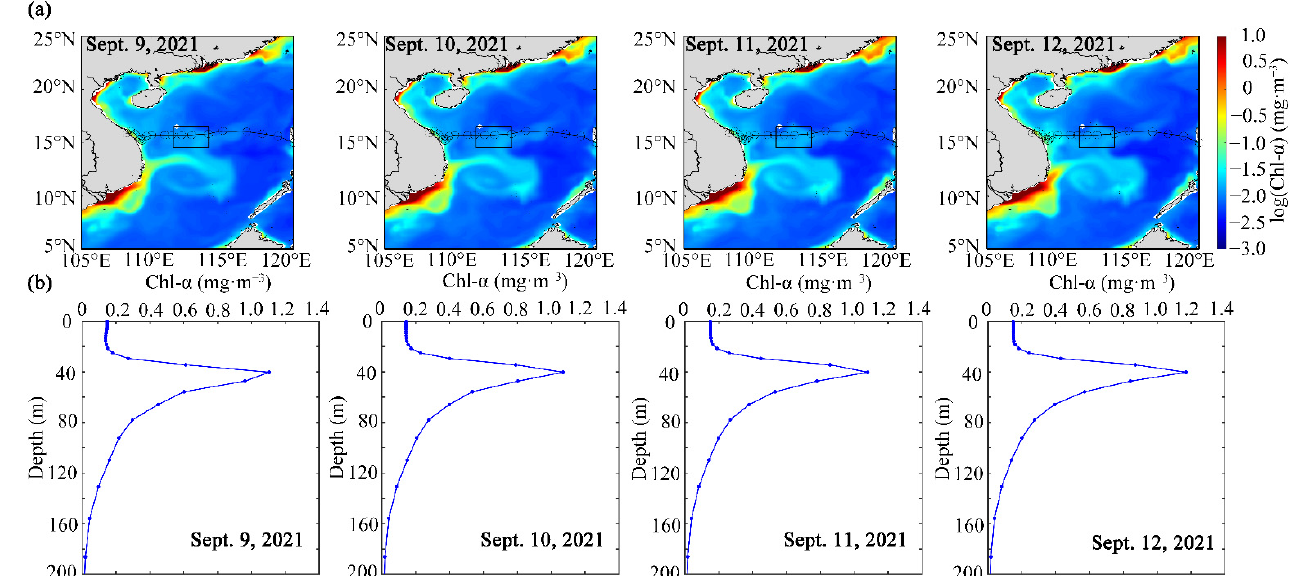
Figure 4. Chl- a changes before and after the passage of STS “Conson”. ( a ) Horizontal distribution of surface Chl- a . ( b ) Vertical profiles of the regional average of Chl- a in the black box of the study area. Before the passing of STS (9–10 September 2021), after the passing of STS (11–12 September 2021). The black hollow circle represented the location of the STS every 6 h, and the black line represented the path of the STS.